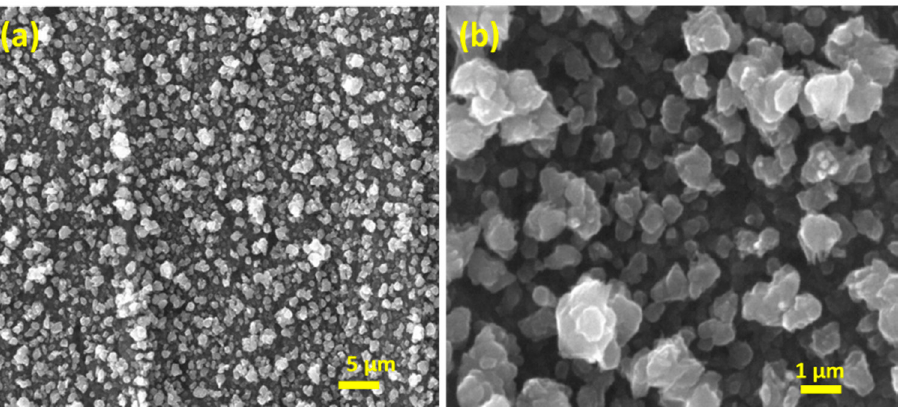
Figure 2. Scanning electron microscopy (SEM) images at ( a ) low, and ( b ) higher magnification, for a Cu foil electrode restructured in 1 M NaOH containing 1 M ethanol at 10 mV s − 1 for 20 cycles over the potential range of − 1.5 to 0.5 V.